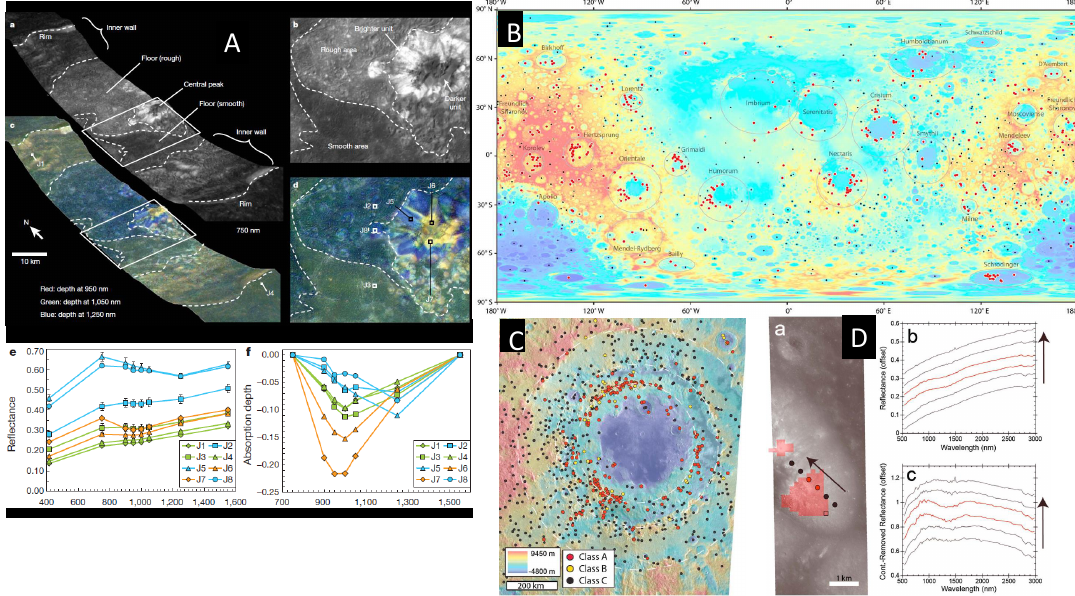
Figure 6. Distribution and geologic setting of purest anorthosite (PAN) exposures. ( A ) Crystalline plagioclase signatures observed at Jackson crater central peaks based on near infrared datasets (Source: [109]) . ( B ) Global distribution of crystalline plagioclase based on a combination of near infrared and thermal infrared datasets. The red dots represent positive identifications. The black dots indicate locations sampled but no plagioclase detection (Source: [110]) . ( C ) Geologic context of purest plagioclase exposures at Orientale basin. Preferential occurrence along the Inner Rook Ring (IRR) is exhibited providing strong depth constraints of purest plagioclase layer (Source: [119]) . ( D ) Relationship of purest plagioclase exposures with featureless spectra (Source: [119])